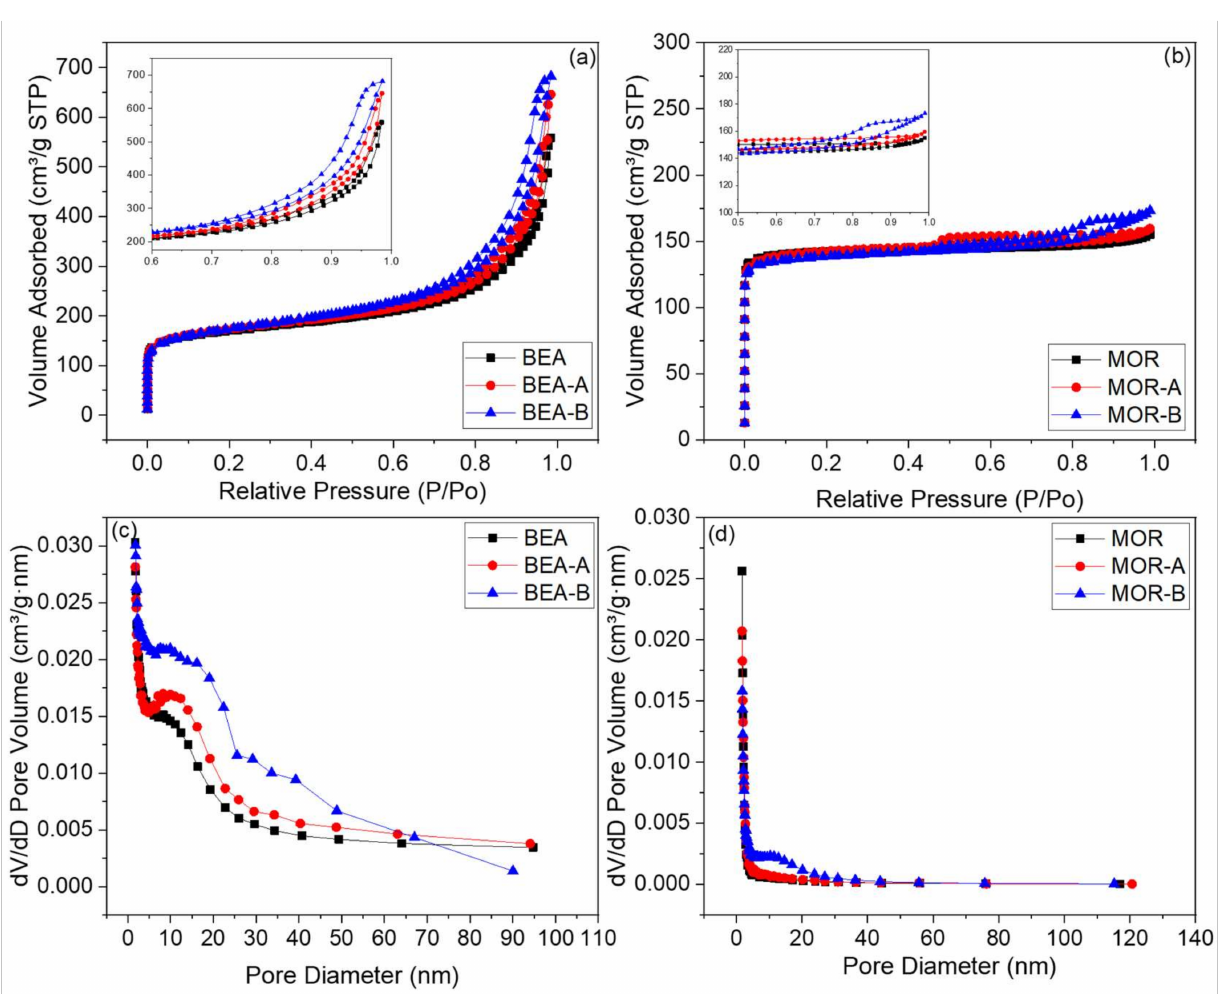
Figure 2. N 2 adsorption–desorption isotherms and pore size distribution curves for the ( a , c ) beta and ( b , d ) mordenite